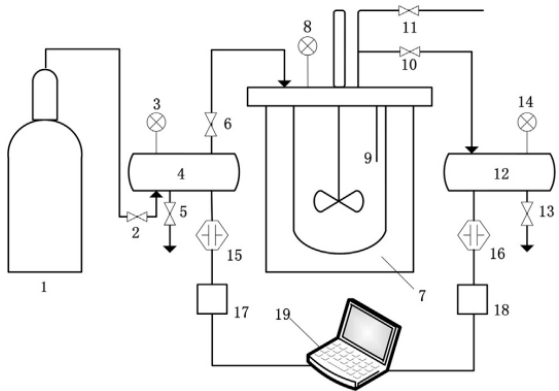
Figure 1. Scheme diagram of the experimental system with (1) hydrogen source; (2), (6), (10) connection valve; (3), (8), (14) pressure gauge; (4), (12) hydrogen reservoir; (5), (11), (13) exhaust pipe valve; (7) stainless steel autoclave; (9) thermocouple temperature control; (15), (16) pressure; copyright (2012), Int. J. Hydrogen Energy.